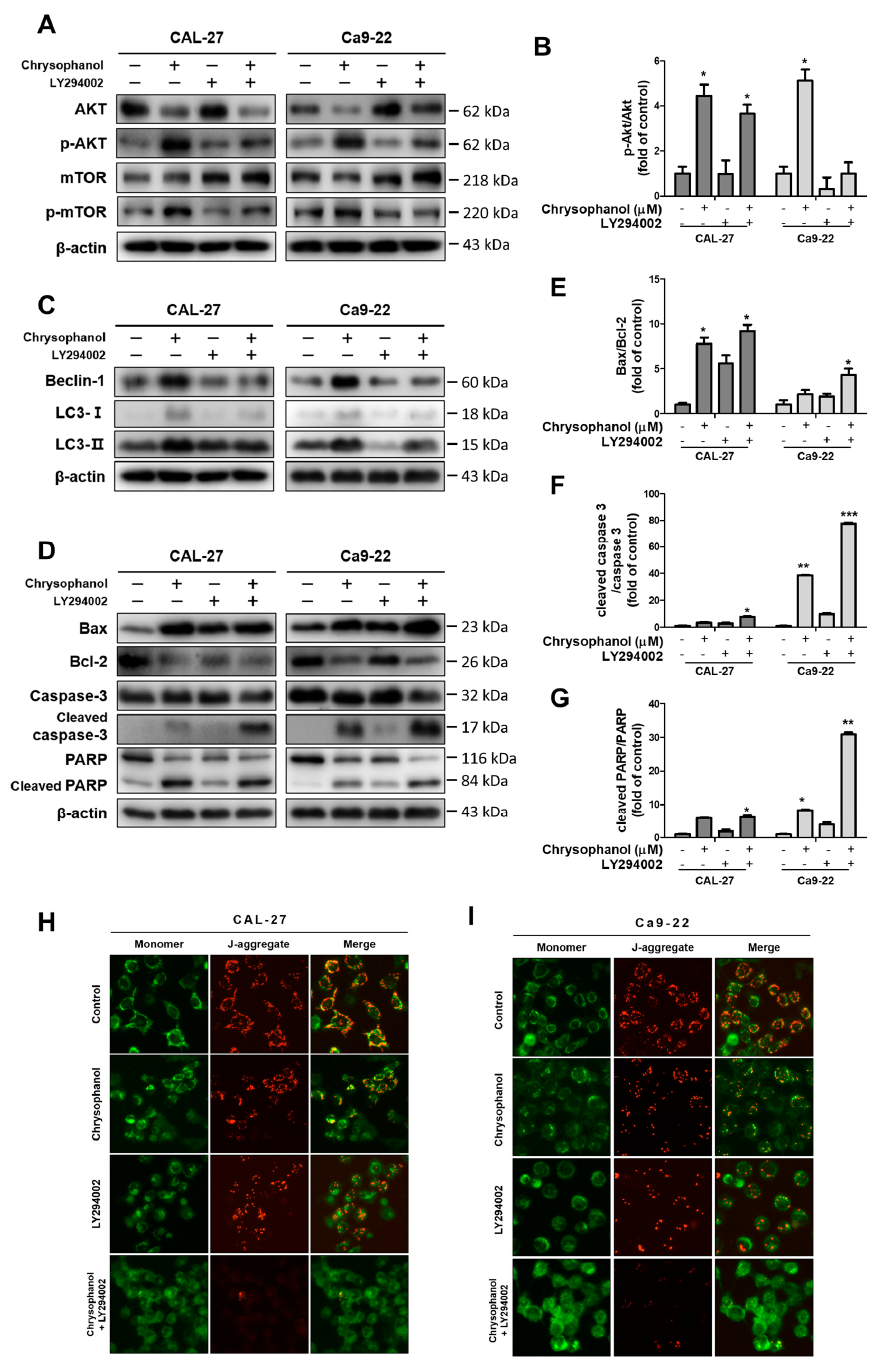
Figure 7. Inhibition of the PI3K/Akt/mTOR pathway promoted chrysophanol-induced apoptosis in CAL-27 and Ca9-22 cells. Both cells were pre-treated with 20 µ M LY294002 for 2 h and then treated with chrysophanol for 24 h. ( A , B ) The expression levels of Akt, p-Akt, mTOR, and p-mTOR were detected using Western blot analyses, and the relative protein p-Akt/Akt ratio was calculated by a Western blot band. ( C – G ) The protein expression levels of autophagy-related proteins (beclin-1, p62, and LC3B) and apoptosis-related proteins (Bax, Bcl-2, caspase -3, and PARP) were evaluated by Western blot analyses, and then the ratios of apoptosis-regulated proteins are indicated in the histogram. ( H , I ) Making observations for JC-1, cells were treated with 150 µ M chrysophanol in the presence or absence of LY294002. Data are expressed as mean ± SD (* p < 0.05, ** p < 0.01, *** p <